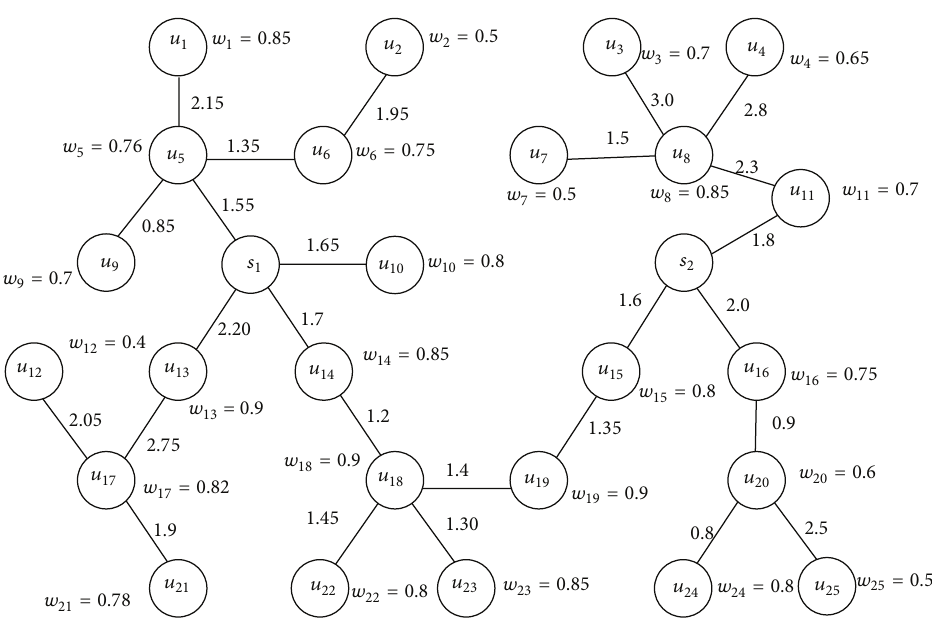
Figure 1: An example tree network.